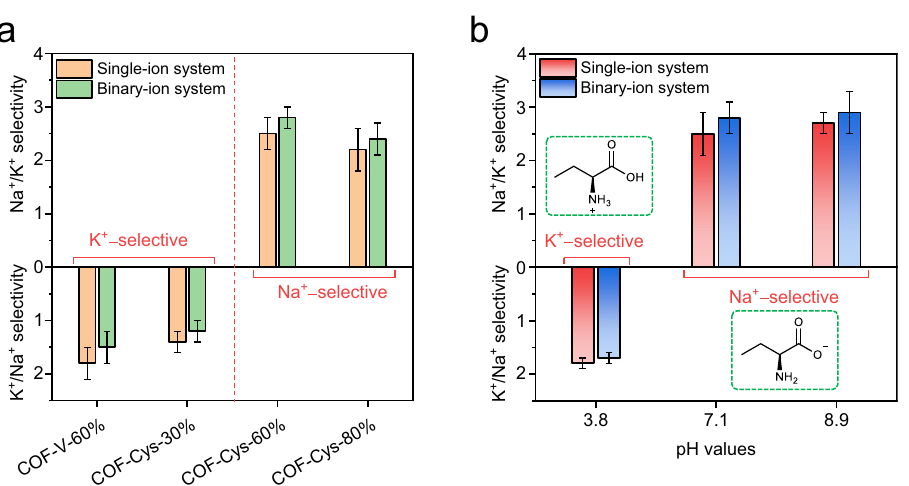
Fig. 3 | Switchable Ion selectivity. a Na + /K + selectivity for COF-V-60% membrane andCOF-Cysmembraneswithvariouscysteineloadings. b In fl uenceofpHonNa + /K +